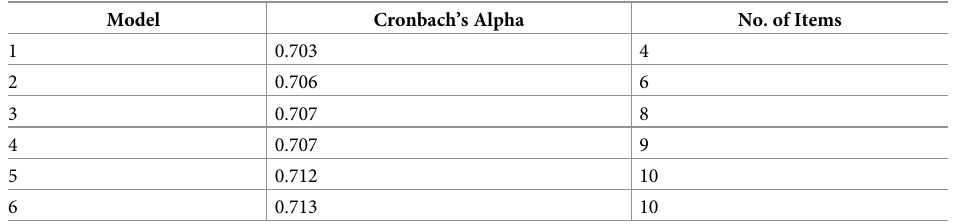
Table 3. Cronbach’s alpha test of